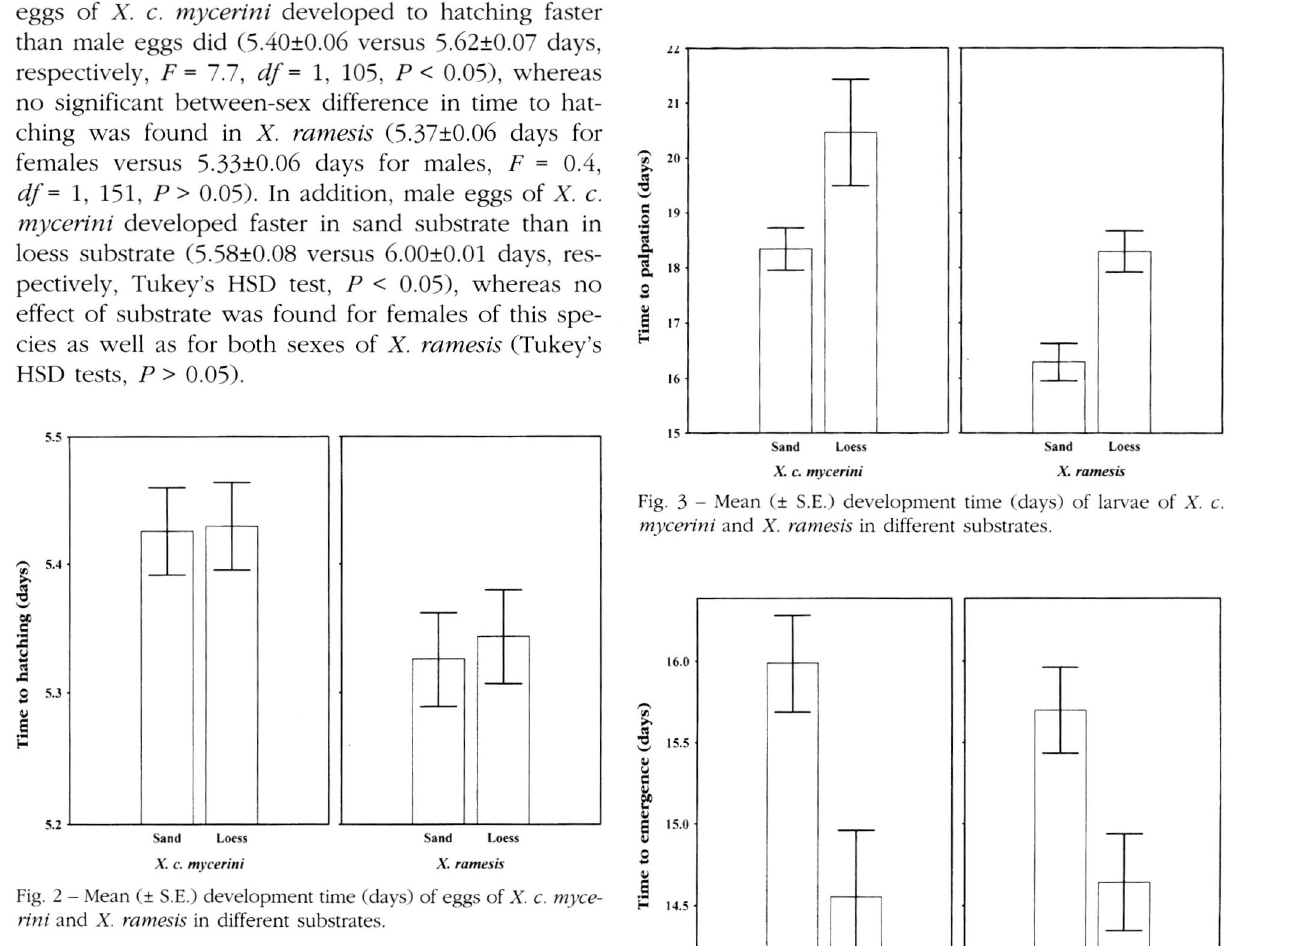
Fig. 2 - Mean (± S.E.) development time (days) of eggs of X. c. myce rini and X. ramesis in different substrates.